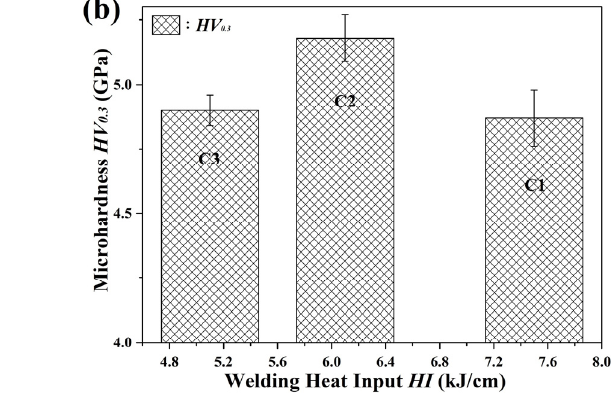
Figure 9. Correlation ( a ) between microhardness HV 0 . 3 and substrate volumetric dilution ratio D v , and ( b ) between microhardness HV 0 . 3 and welding heat input HI for the PTA-welded coatings.